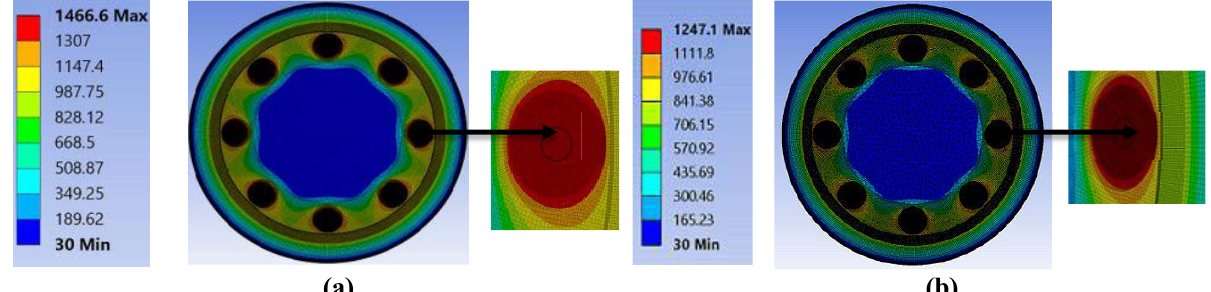
Figure 6. Temperature contour of Test section a) 3 % decay heat and b) 2% decay heat